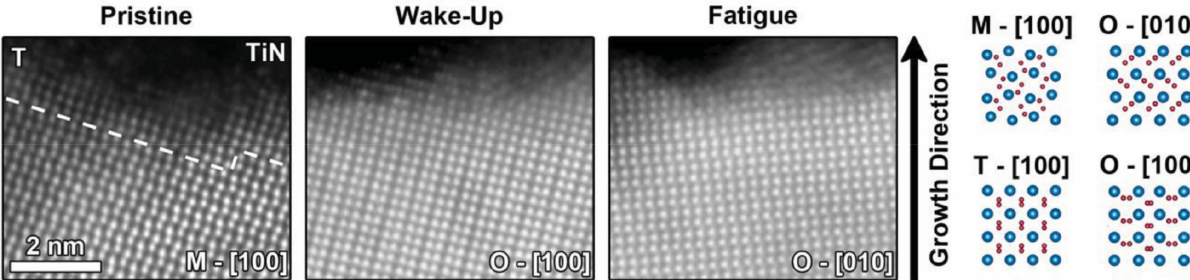
Figure 8. STEM images of ferroelectric HfO 2 in Pristine, Wake-up, Fatigue: observation of the phase transition by cycling [29]. Copyright 2016,